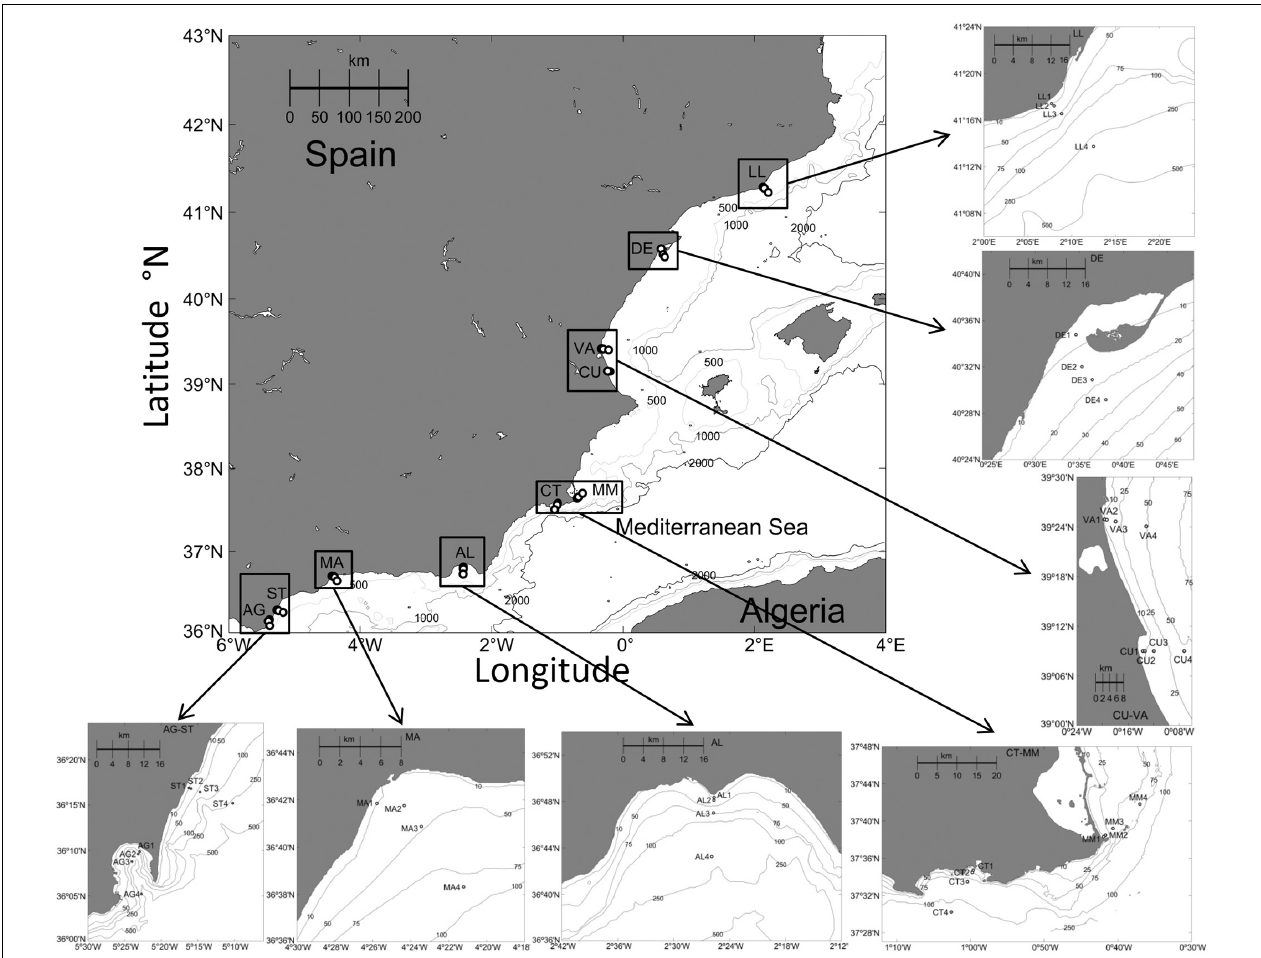
FIGURE 1 | Transects location map in the W Mediterranean Sea (AG: Algeciras, AL: Almería, CT: Cartagena, CU: Cullera, DE: Delta del Ebro, LL: Llobregat, MA: Málaga, MM: Mar Menor, ST: Sotogrande, VA: Valencia).